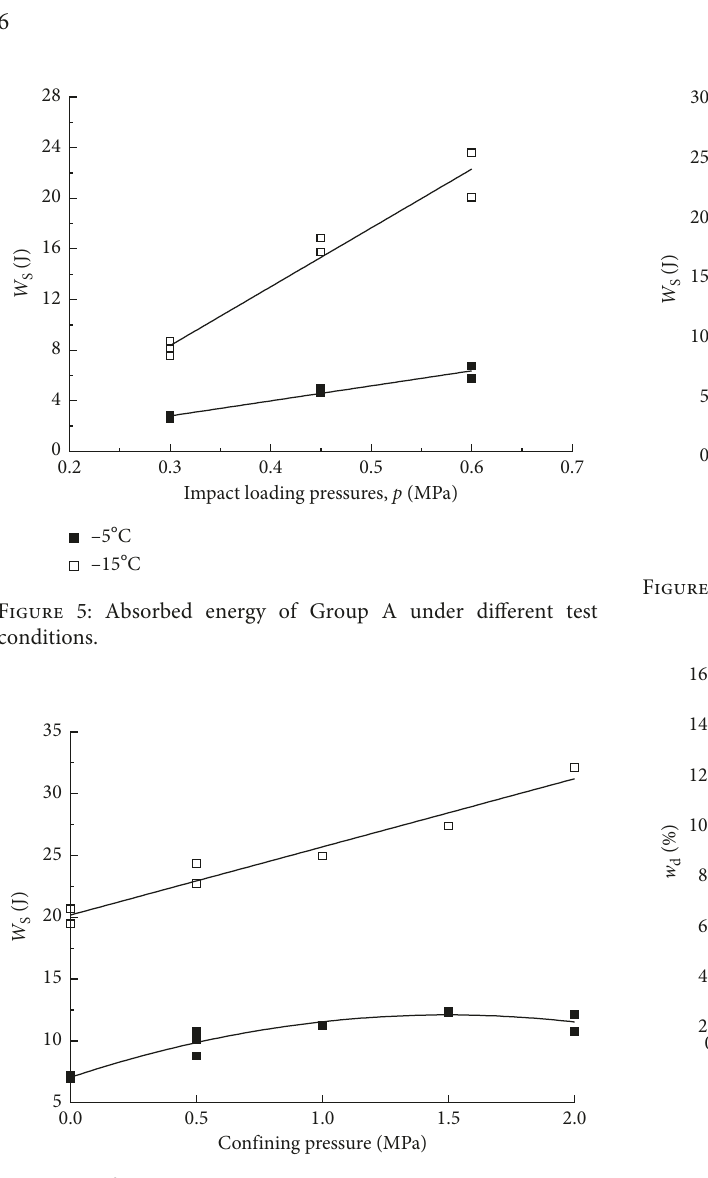
Figure 8: Relation between energy absorbency rate and impact loading pressures of Group